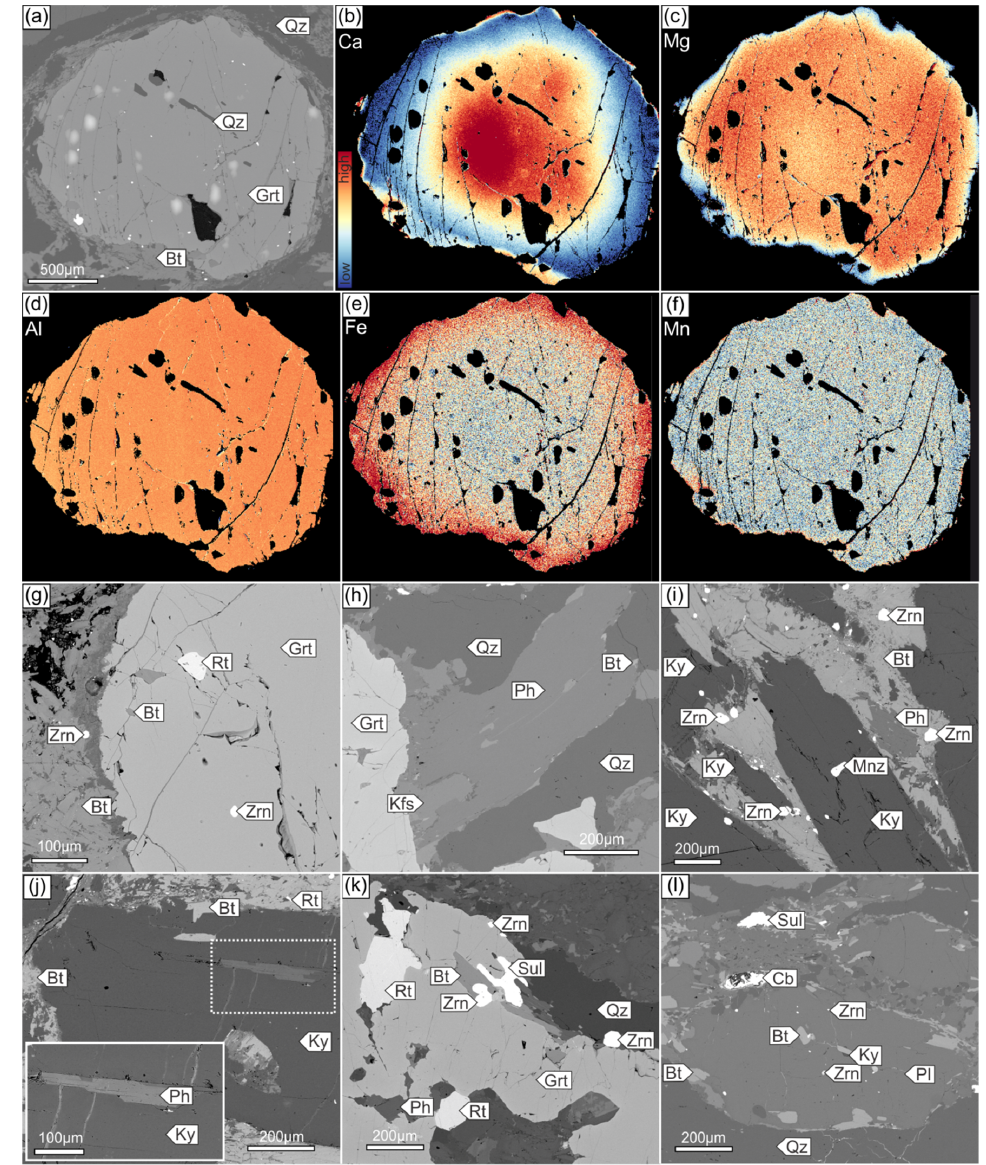
Figure 3. Back-scattered electron (BSE) and wavelength-dispersive X-ray spectrometry (WDS) maps of the rock forming minerals in migmatitic paragneisses. ( a ) BSE image of the garnet (MJ1805-A) presented in the WDS maps in ( b – f ). The bright spots on the BSE image mark the area of removed graphite coating. These areas were removed from the X-ray maps during data treatment in XMapTools v.2.3.1 [56]. WDS maps show the peak counts measured only in the garnet grain. ( b ) X-ray map of Ca, ( c ) X-ray map of Mg. ( d ) X-ray map of Al. ( e ) X-ray map of Fe. ( f ) X-ray map of Mn. ( g ) BSE image of garnet hosting inclusions of zircon and rutile (MJ1805-A). ( h ) A phengite grain breaking down to biotite and K-feldspar in the garnet pressure shadow (MJ1802-A). ( i ) Kyanite porphyroblasts enveloped by biotite and partially decomposed phengite. Note the abundant zircon and monazite grains (MJ1805-A). ( j ) A phengite grains hosted in kyanite porphyroblast (MJ1805-A). ( k ) Partially melted garnet with abundant zircon grains located at the garnet grain edge (MJ1802-A). ( l ) Plagioclase grain in the neosome. Note the unusually bright a REE-bearing carbonate (MJ1802-A). Mineral abbreviations: garnet (Grt), rutile (Rt), biotite (Bt), zircon (Zr), quartz (Qz), K-feldspar (Kfs), phengite (Ph), kyanite (Ky), monazite (Mnz), sulfide (Sul), carbonate (Cb), plagioclase (Pl).